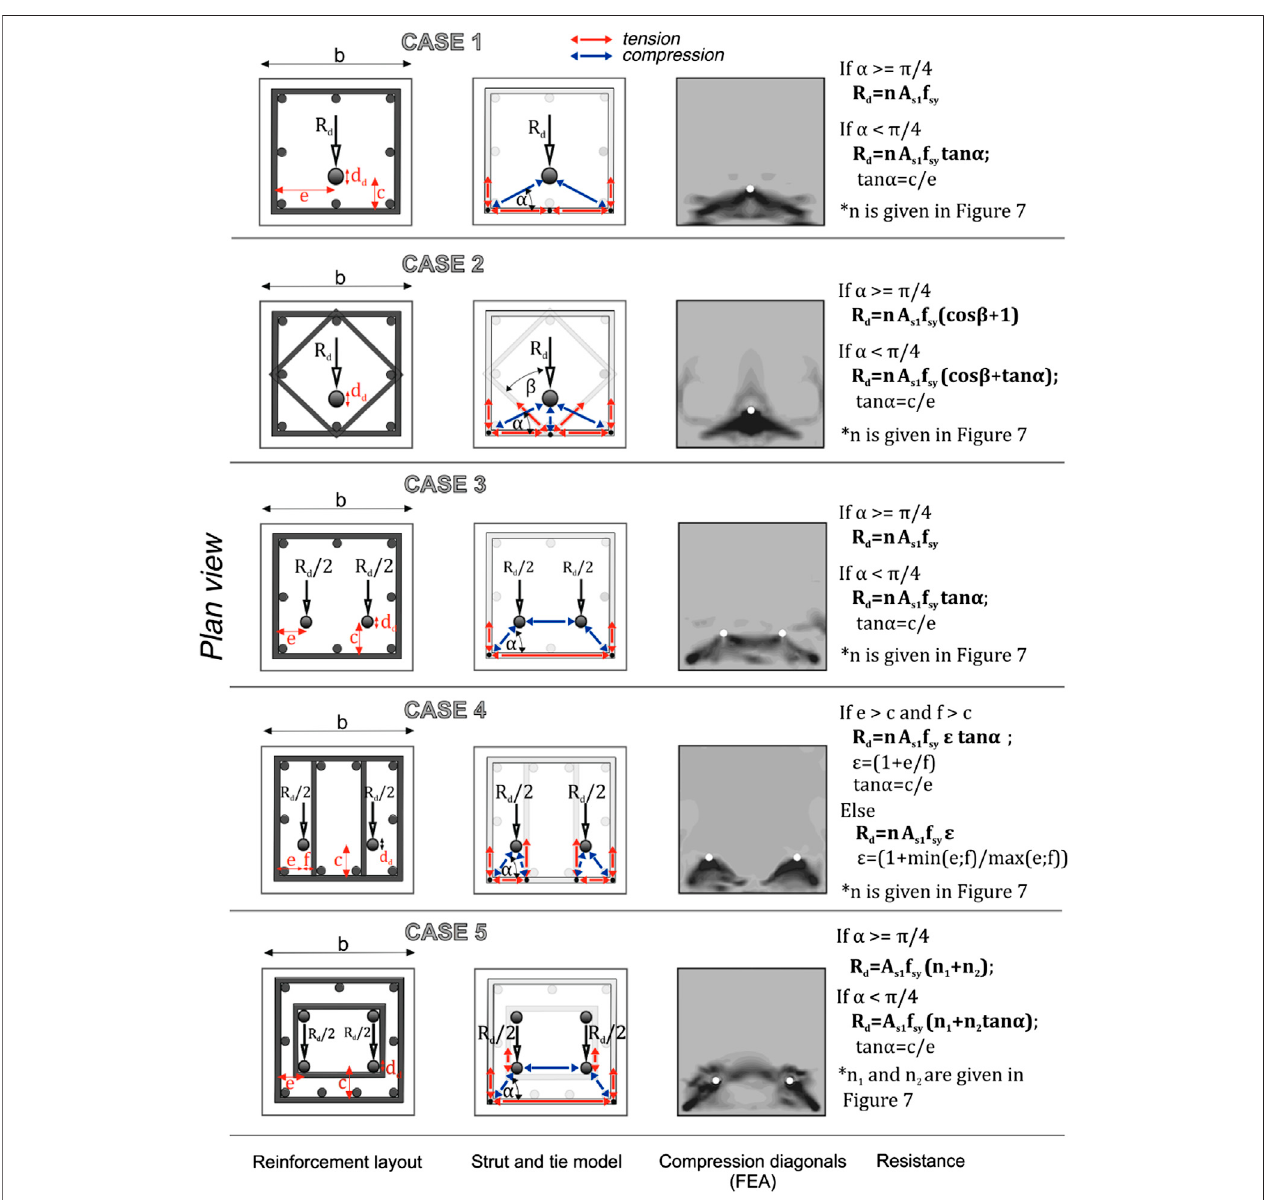
FIGURE 3 | Calculation of the strength capacity of eccentric dowel connection, adopted from Zoubek et al. (2015).